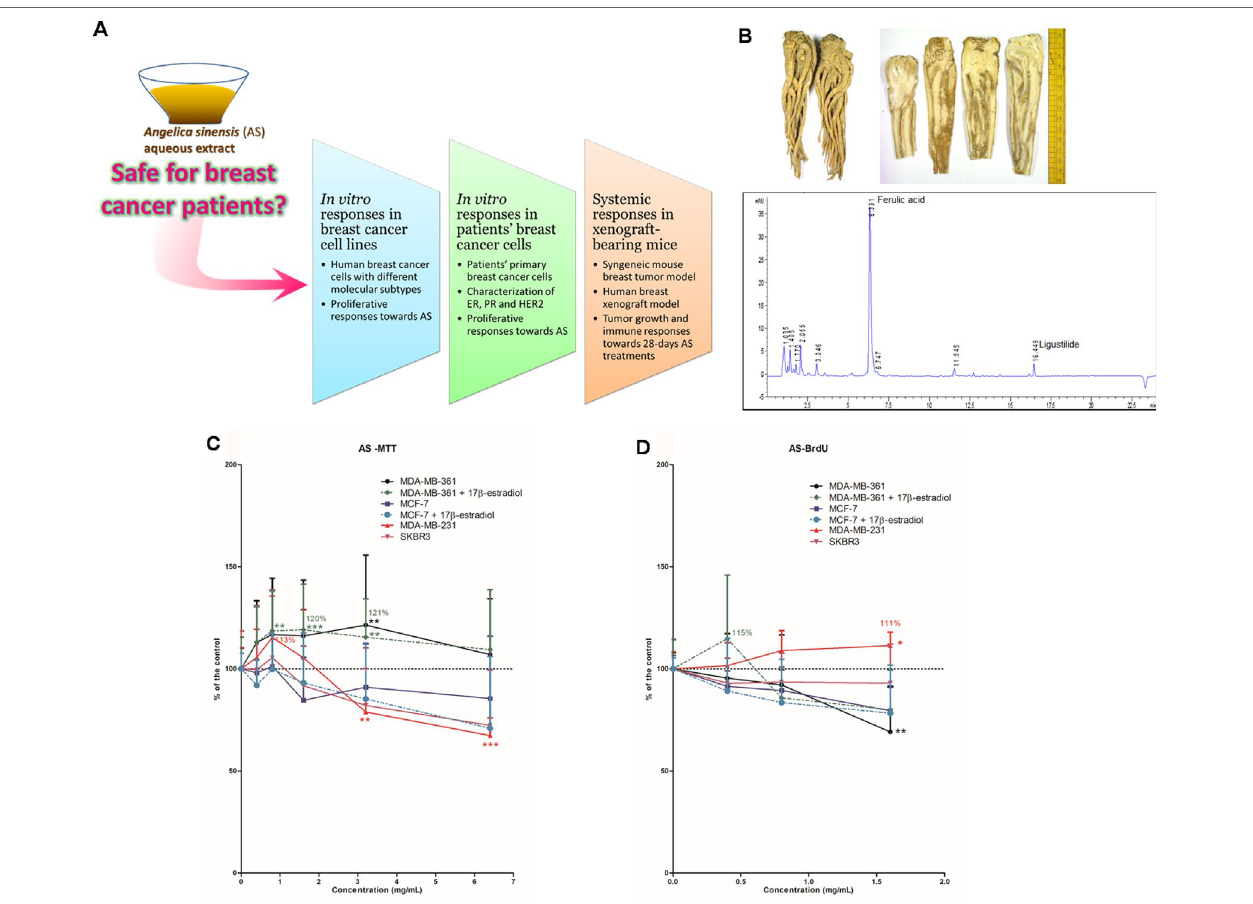
FIGURE 1 | Study flow and chemistry of Angelicae Sinensis Radix. (A) Schematic diagram showing the experimental flow of the present pre-clinical study. (B) Dried herb (whole piece and slices) of Angelicae Sinensis Radix (AS) and the representative UPLC chromatogram of AS extract. (C, D) Effects of AS aqueous extract on human breast cancer cells. (C) Cell viability and (D) cell proliferation in MDA-MB-361, MCF-7, MDA-MB-231, and SKBR3 cells. Cells were treated with various concentrations of AS extract (A) 0.4–6.4 mg/ml for cell viability assay; (B) 0.4–1.6 mg/ml for proliferation assay) alone or in combination with 0.1 µM of 17 β -estradiol for 48 h. Data were expressed as the mean percentage of the untreated control (in C and D : three independent experiments with five replicates each; in B : two independent experiments with three replicates each). Statistical differences were determined by one-way ANOVA, followed by Dunnett Test, with * p < 0.05, ** p < 0.01, *** p < 0.001 against untreated